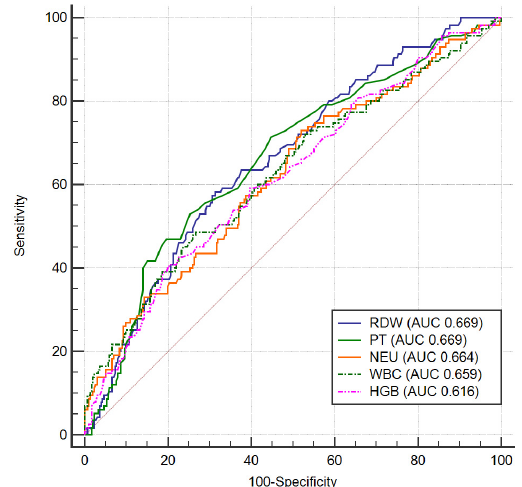
Figure 3. ROC curves for complications prediction in ACS. Legend: RDW—red cell distribution width; PT—prothrombin time; NEU—neutrophils; WBC—white blood cells; HGB—hemoglobin; ACS—acute coronary syndrome.